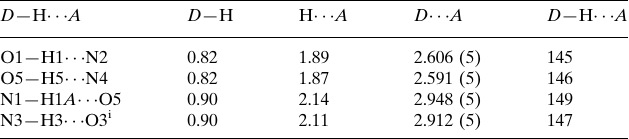
Hydrogen-bond geometry (A˚ , (cid:2)